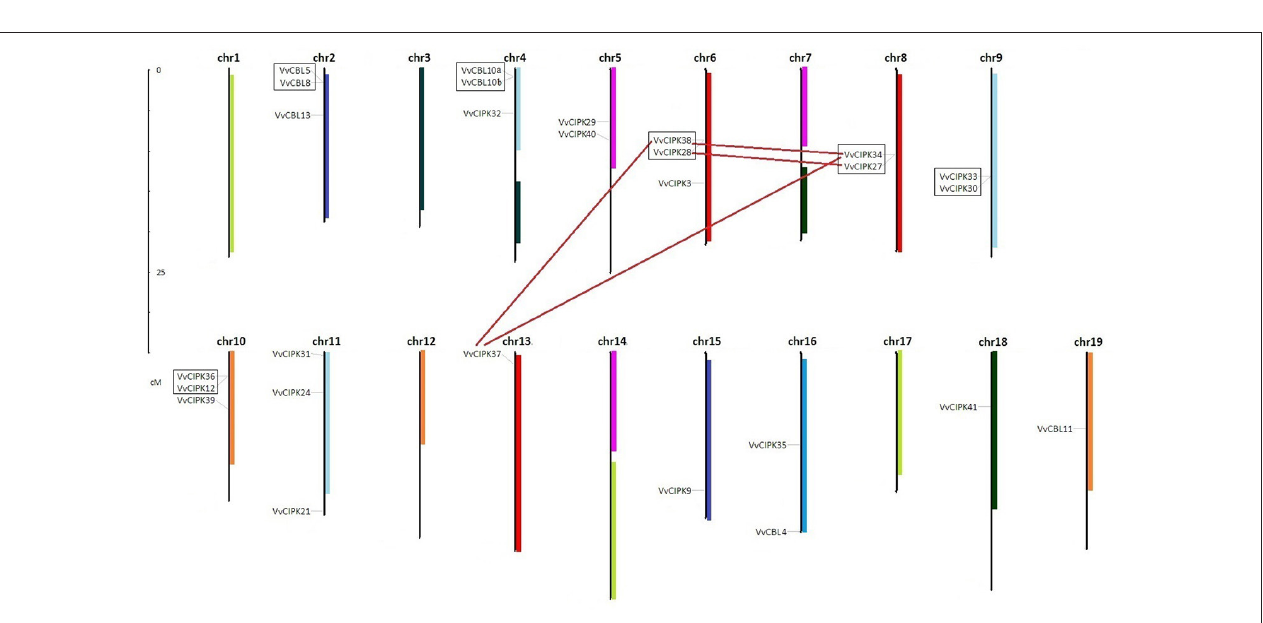
FIGURE 3 | Chromosomal locations of grapevine CBL and CIPK genes. The 7 CBL and 20 CIPK genes of grapevine were mapped to 13 chromosomes in which the hidden VvCBL12 were mapped to chromosomes Un. The segmental duplicated gene pairs were connected by lines. The tandem duplicated gene pairs were marked with